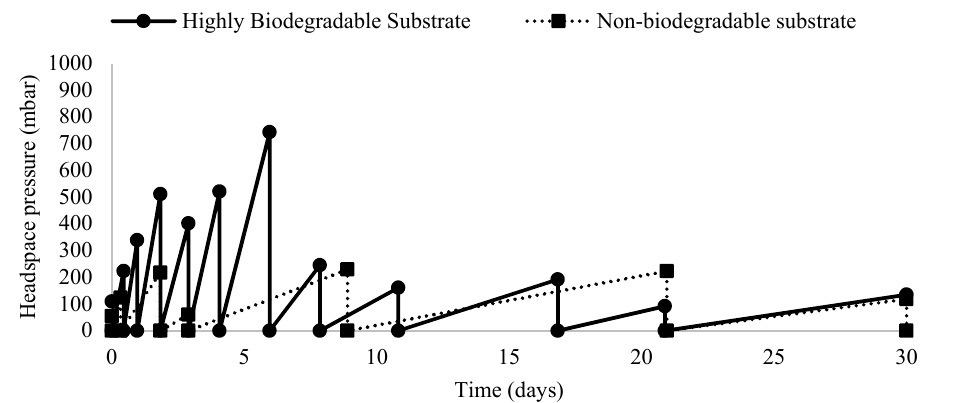
Figure 8. Example of headspace pressure releases for a highly biodegradable and non-biodegradable substrate .